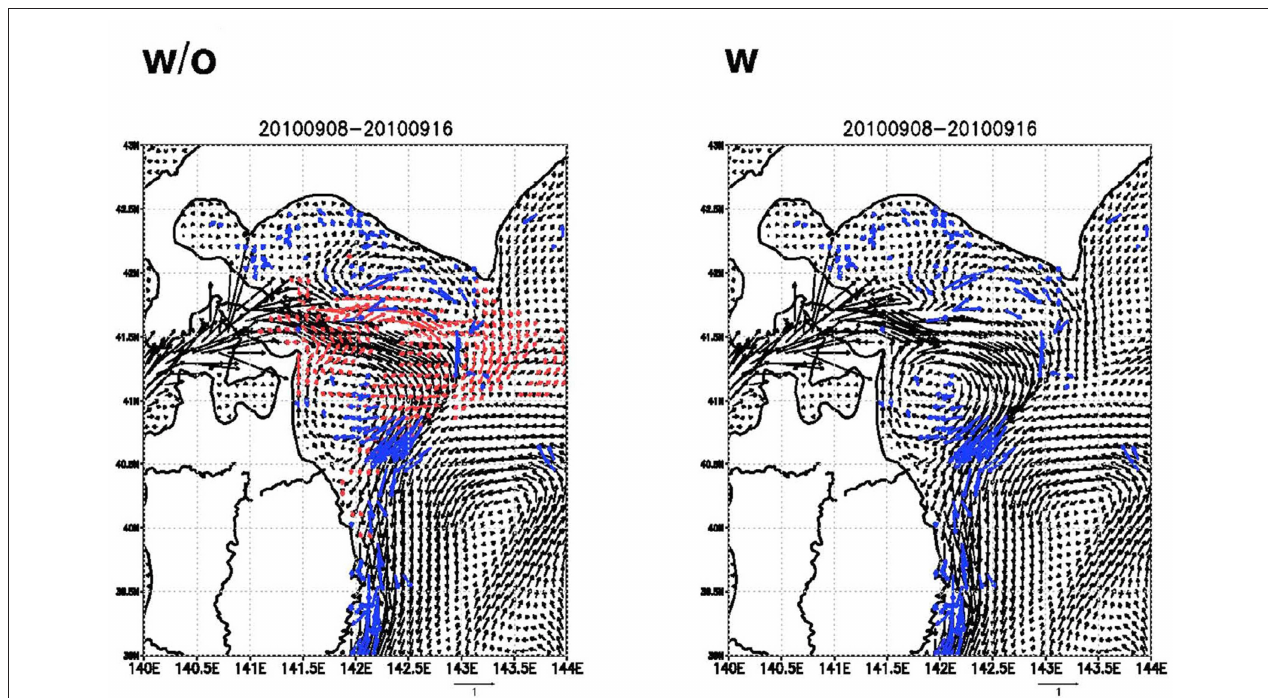
FIGURE 6 | Model current distributions at 5m depth averaged during the target period. Left (right) panels indicate the results without (with) the assimilation of the seabird drift in the 2010 season. The composite drift data are represented by the blue colored vectors. Difference larger than 0.1m s − 1 in magnitude of the flows with and without the assimilation is indicated by the red colored vectors in the left panels. Numerics at the top of the figure denote the period. The figures adapted from data presented in Miyazawa et al. (2015) which is licensed under a Creative Commons Attribution 4.0 International